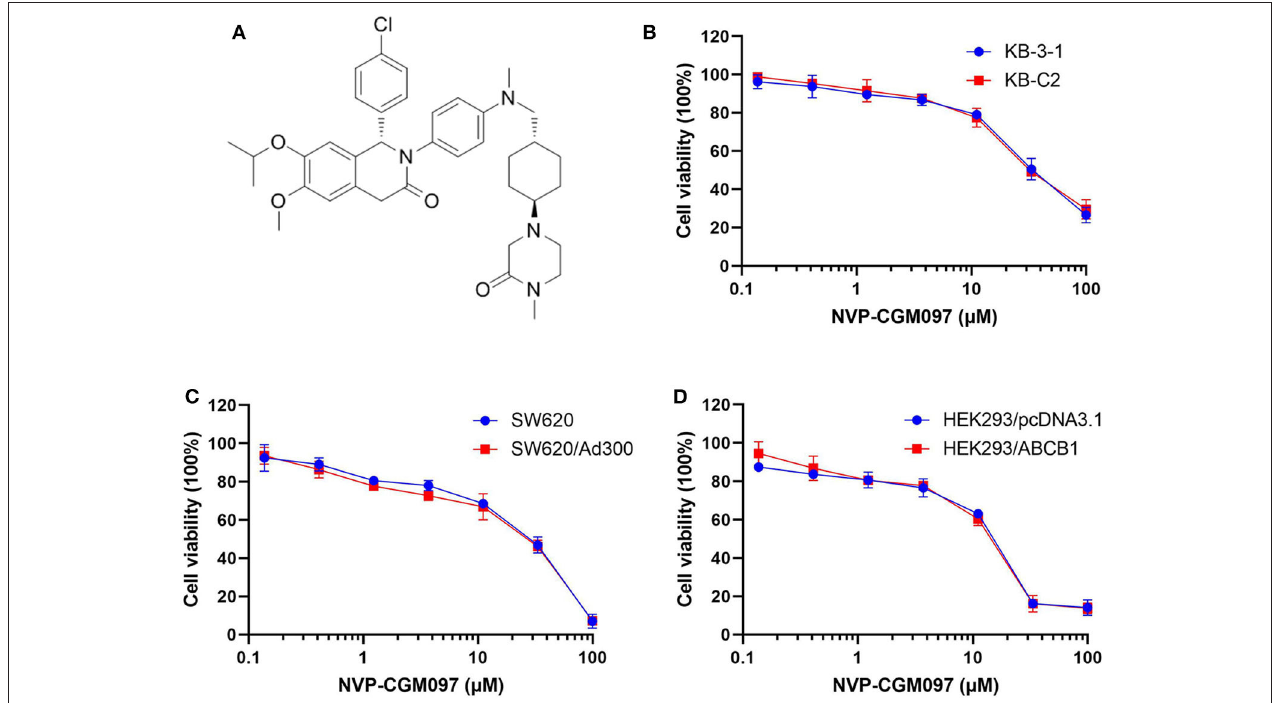
FIGURE 1 | Chemical structure of NVP-CGM097 and concentration-dependent viability curves for parental and ABCB1-overexpressing cells incubated with NVP-CGM097. (A) Chemical structure of NVP-CGM097. (B) Cytotoxicity curves for KB-3-1 and KB-C2 cells incubated with NVP-CGM097 for 72h. (C) Cytotoxicity curves for SW620 and SW620/Ad300 cells incubated with NVP-CGM097 for 72h. (D) Cytotoxicity curves for HEK293/pcDNA3.1 and HEK293/ABCB1 cells incubated with NVP-CGM097 for 72h. The cell viability was determined by MTT assay. Data are expressed as mean ± SD, and representative of three independent experiments in triplicate are shown.